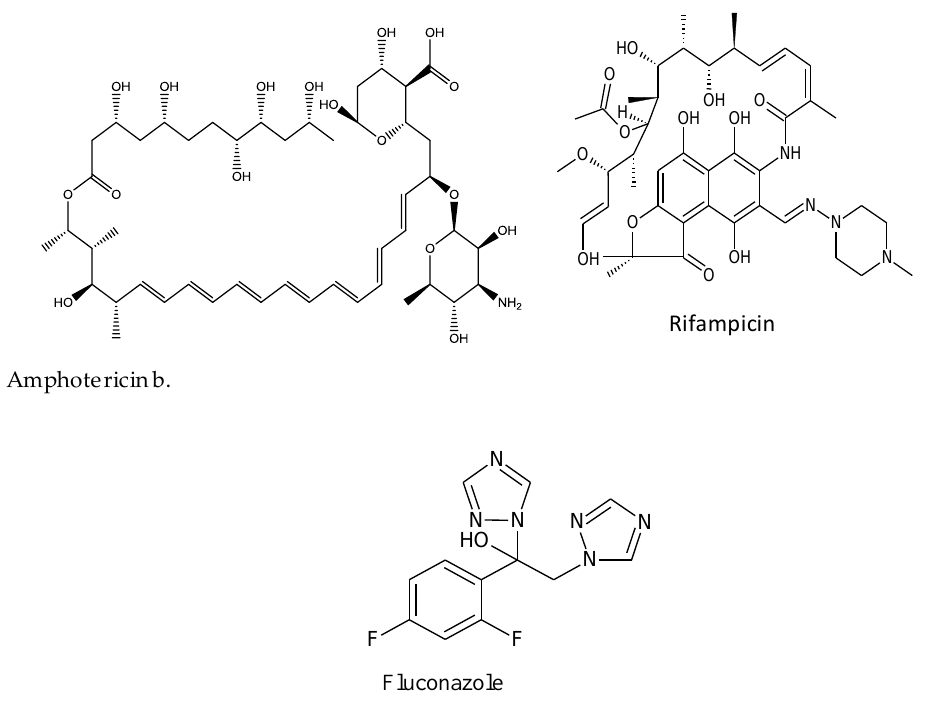
Figure 1. The chemical structures of amphotericin b (Amp b), fluconazole (Flu), and rifampicin (Rif). As depicted, each of these drugs have unique structural features that can influence membrane integrity.